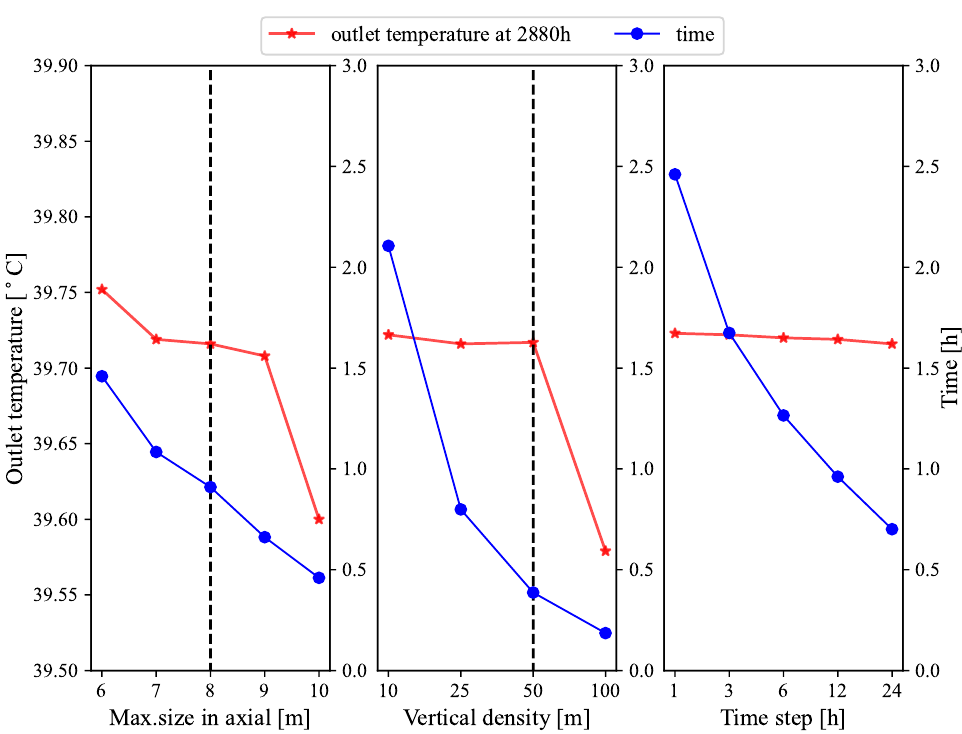
Figure 1. The outlet temperature and simulation time of OGS under different grid densities and time steps.